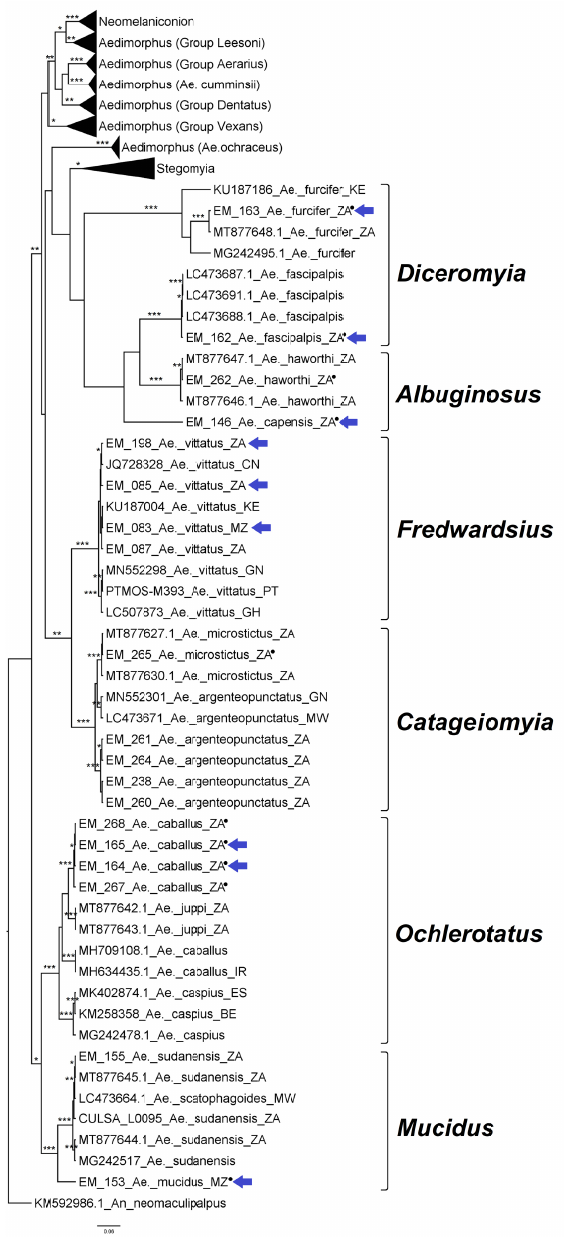
Figure 7. Phylogenetic analysis of 172 partial coxI nucleotide sequences from mosquitoes of the genus Aedes , presenting the subgenera Diceromyia , Albuginosus , Fredwardsius , Catageiomyia , Ochlerotatus ,